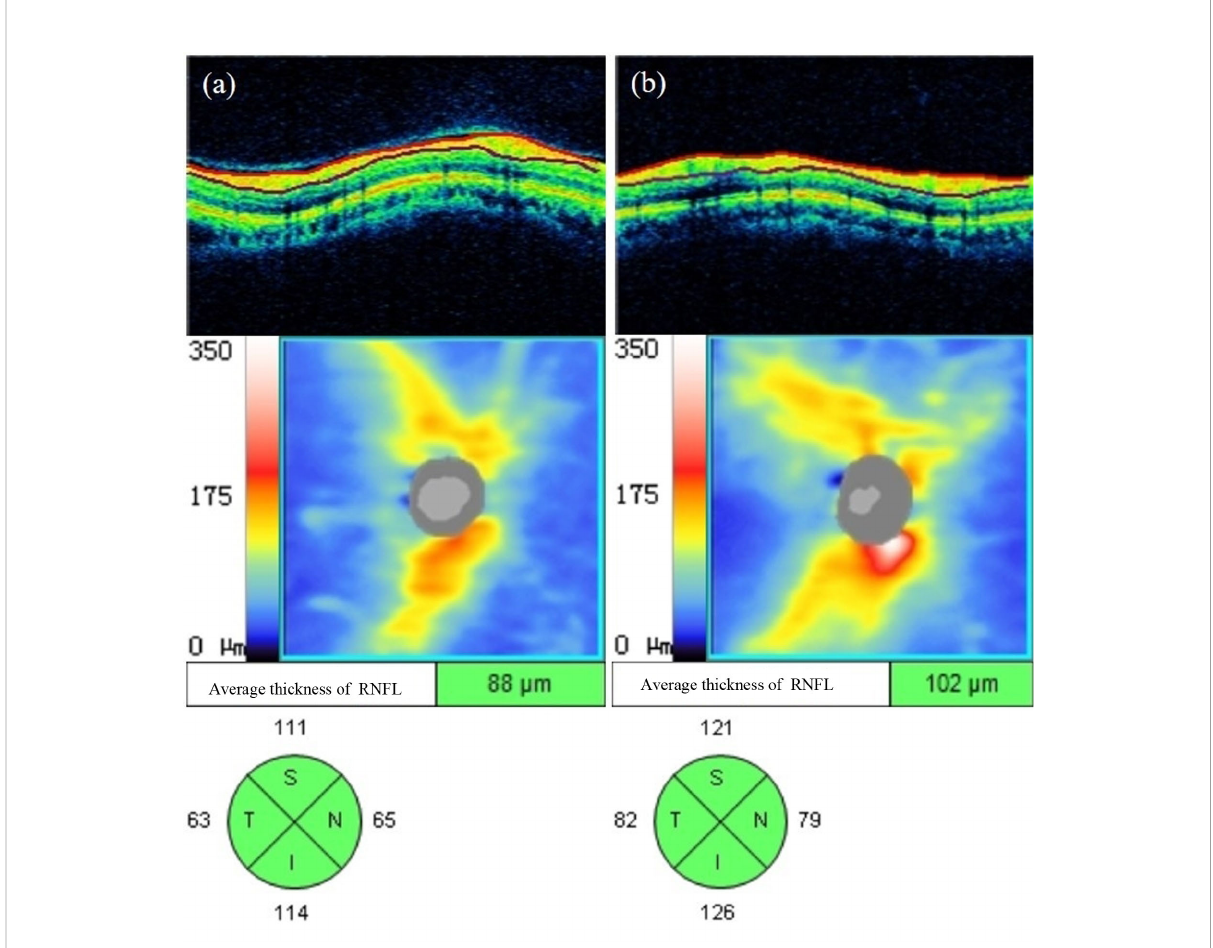
FIGURE 6 Representative OCT images of RNFL thickness measurements around the optic disc of the affected eyes in the NDR group and the tested eyes in the control group. (A) Results of OCT annular ring B scan, RNFL thickness fi gure, and mean and each quadrant RNFL thickness around the optic disc automatically measured by the system software of the right eye of a 63-year-old male NDR patient. (B) Results of OCT annular ring B scan, RNFL thickness fi gure, and mean RNFL thickness and RNFL thickness in each quadrant around the optic disc automatically measured by the system software of the right eye of a 54-year-old female control. The average RNFL thickness around the optic disc and each quadrant thickness of the NDR affected eyes were smaller compared with the examined eyes of the control. NDR, diabetes mellitus without diabetic retinopathy; RNFL, retinal nerve fi ber layer; OCT, optical coherence tomography.